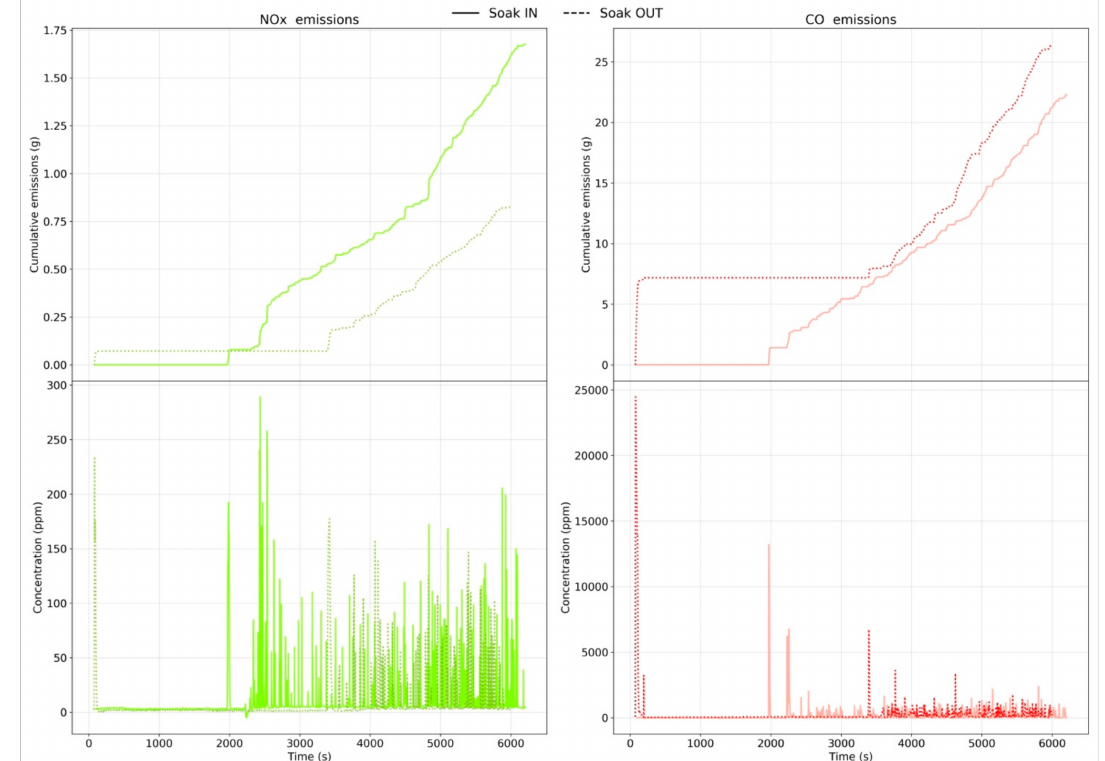
Figure 4. NOx and CO emissions on RDE compliant tests. Both tests were performed with an initial state of charge (SOC) equal to 100% and in “full electric” mode of operation. Solid lines refer to a test performed after soaking the vehicle in a closed area at 20 ◦ C, dashed lines refer to a test performed after a soaking performed outside at 1 ◦ C ca. See the Methods section for additional